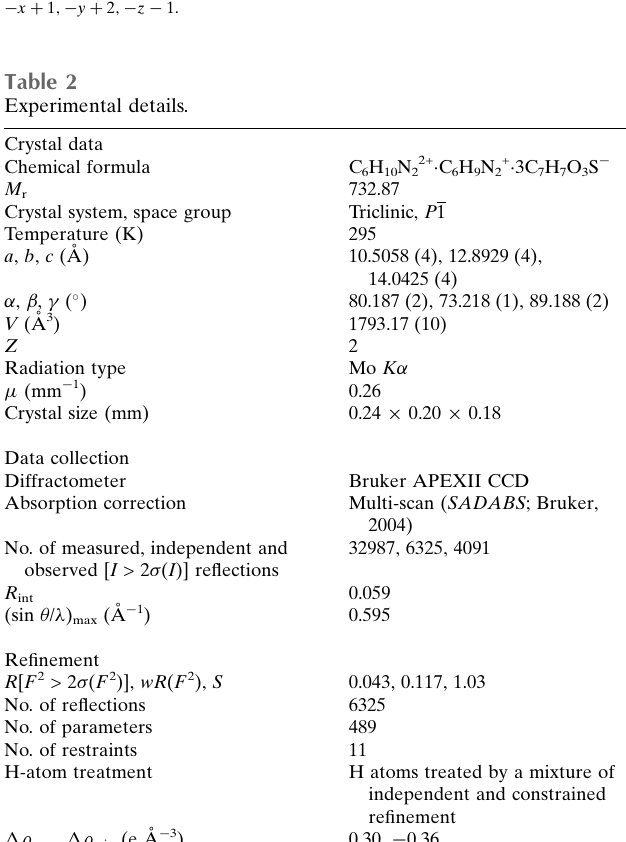
in a beaker covered with perforated polythene. Colourless crystals of the title molecular salt were recovered after one week.